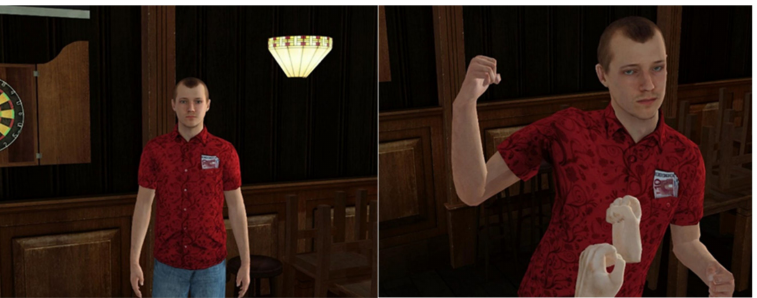
Figure 5. Left : The cheating avatar walking toward the participant in the reactive condition. Right : In case the participant hit the avatar, the avatar fought back. In front, a virtual display of the participant’s hands is